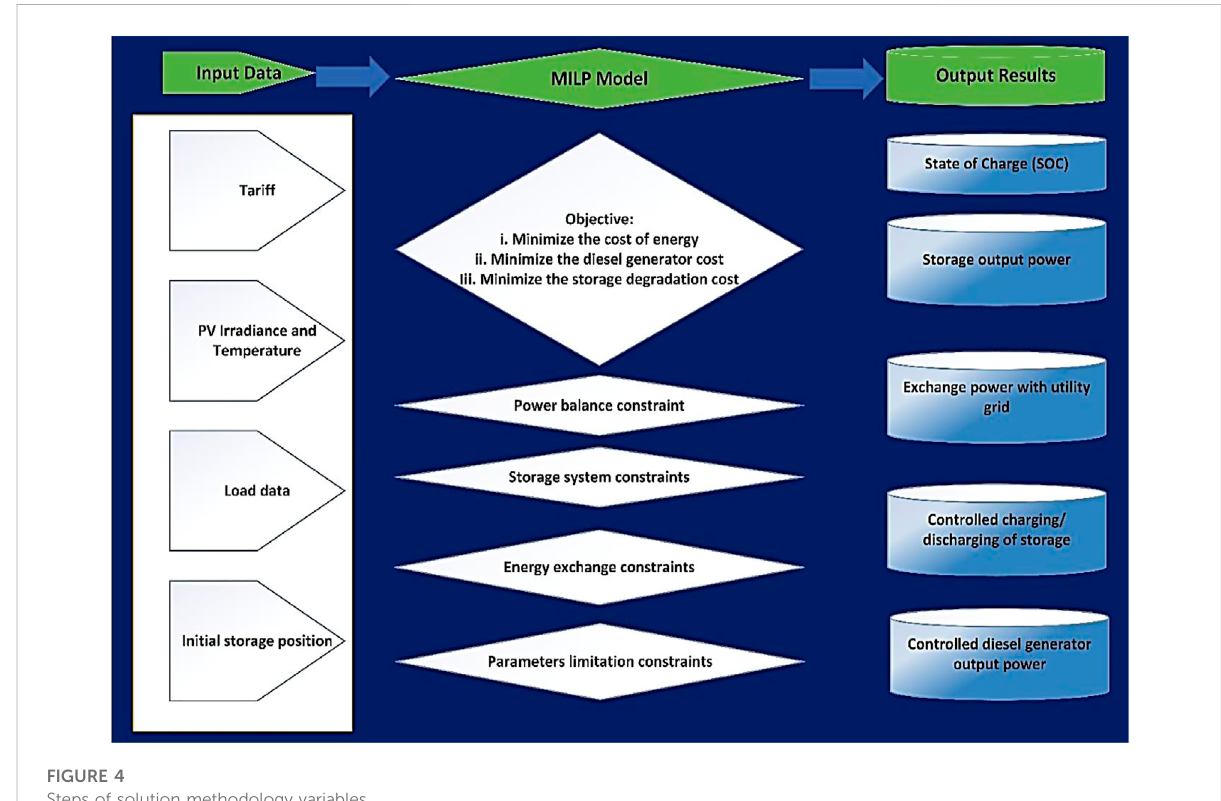
FIGURE 4 Steps of solution methodology variables.